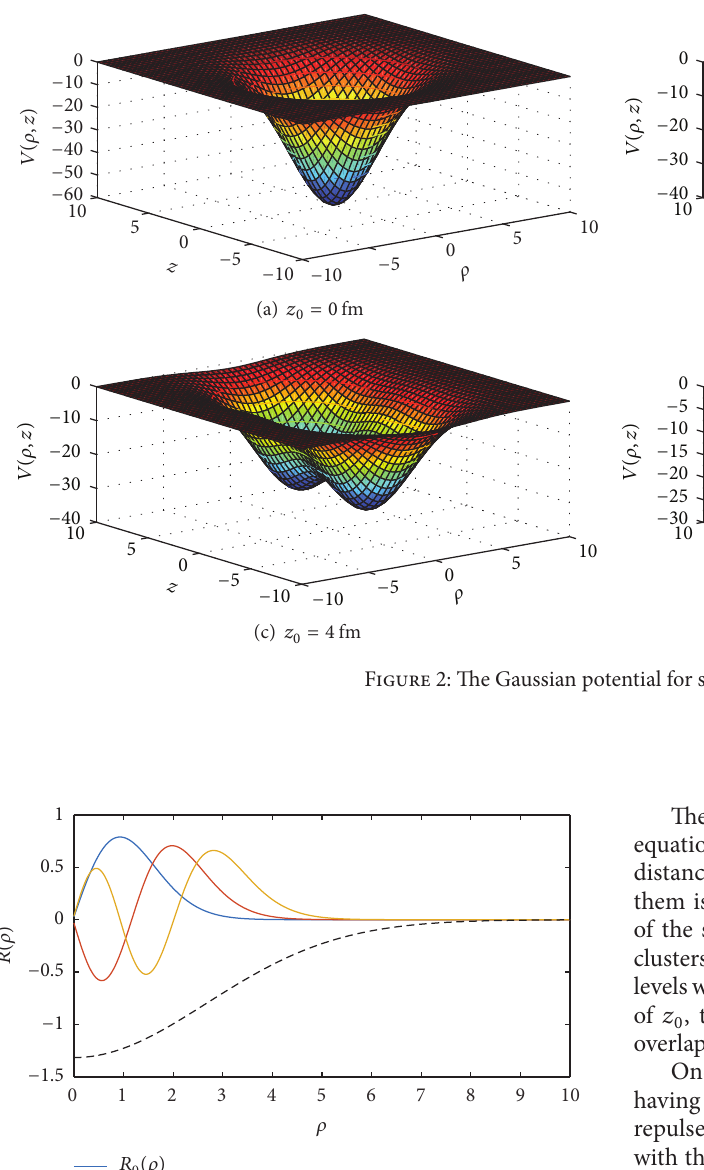
Figure 3: The eigenvectors 𝑅 𝑛